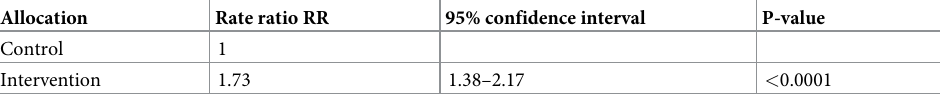
Table 3. Difference in response rate for the intervention and control group (rate ratio, relative risk). The model was adjusted for age and gender � .